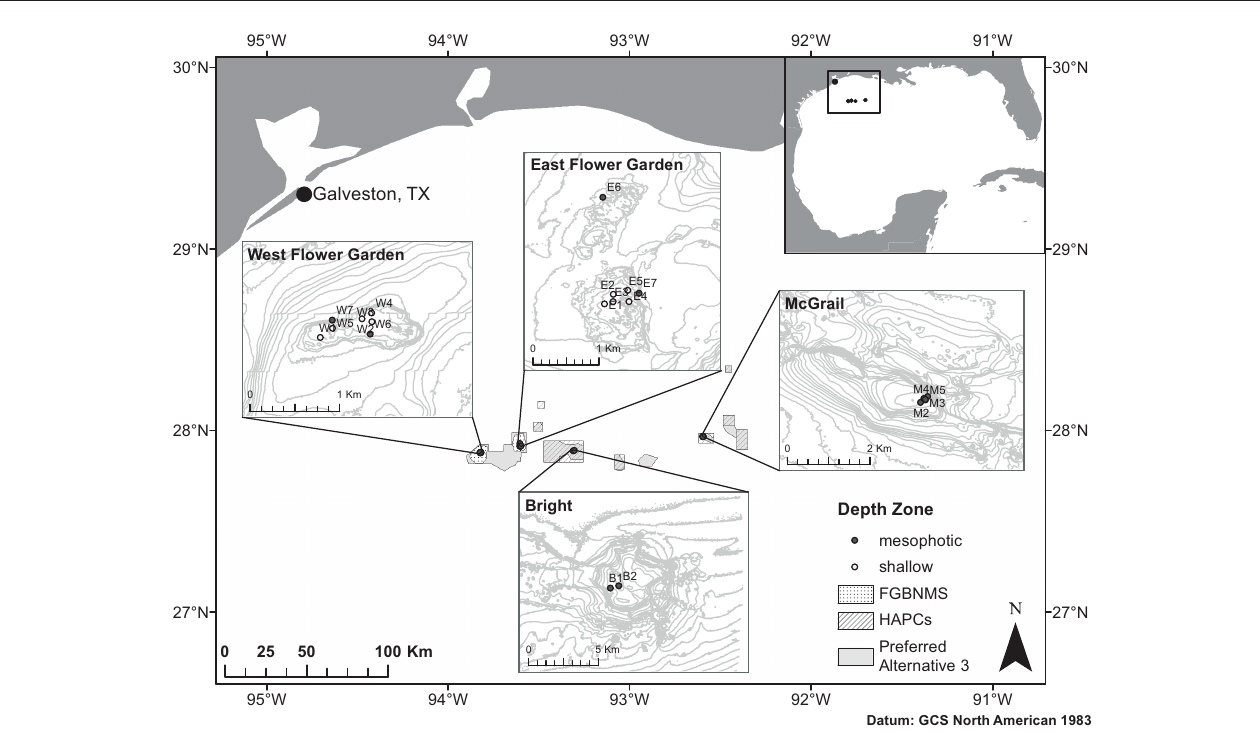
FIGURE 1 | Map of the NW GOM and sampling locations across four reef banks including West Flower Garden Bank (WFGB), East Flower Garden Bank (EFGB), Bright Bank (BRT), and McGrail Bank (MCG). FGBNMS boundaries indicated by spotted polygons, HAPCs by crosshatched polygons, and the Preferred Alternative 3 expansion boundaries shown as gray polygons. Sampling site names as in Table 1